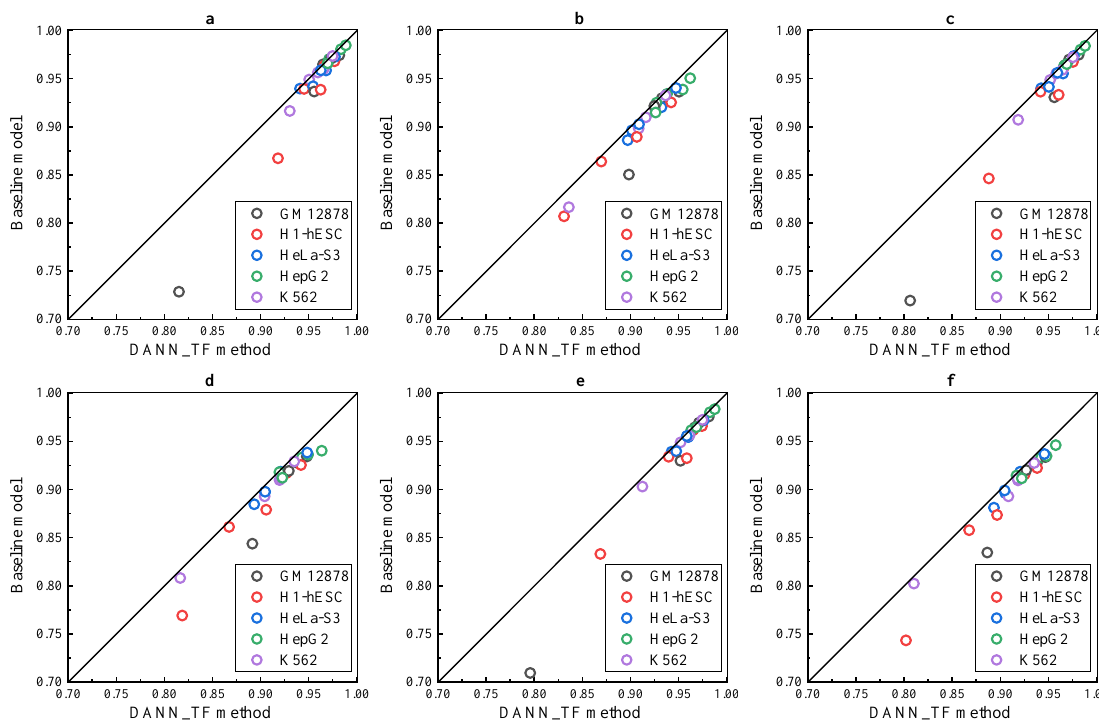
Figure 2. Performance for semi-supervised prediction. AUC and F1 score of DANN_TF and the baseline method for ( a , b ) predictions with 50% labeled training data, ( c , d ) predictions with 20% labeled training data and ( e , f ) predictions with 10% labeled training